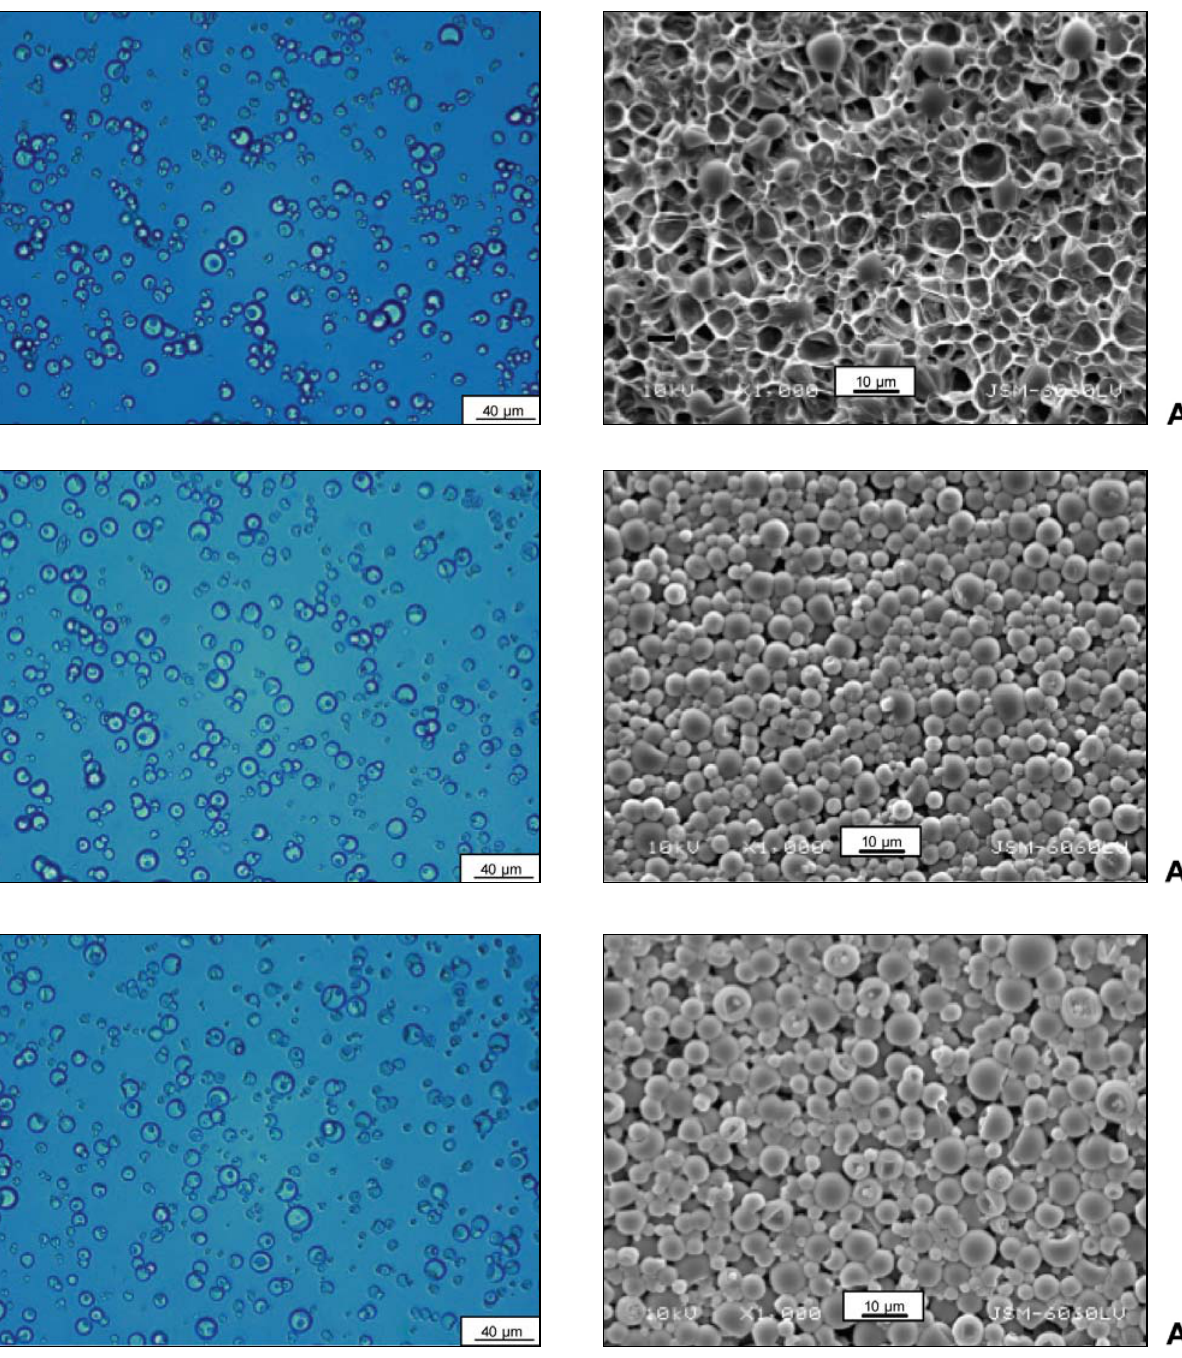
Figure 3. Optical microscopy (left) and SEM images (right) of the (polyurea) microcapsules with different membrane thicknesses (A1 < A2 < A3, for a description, see Table 1 and the